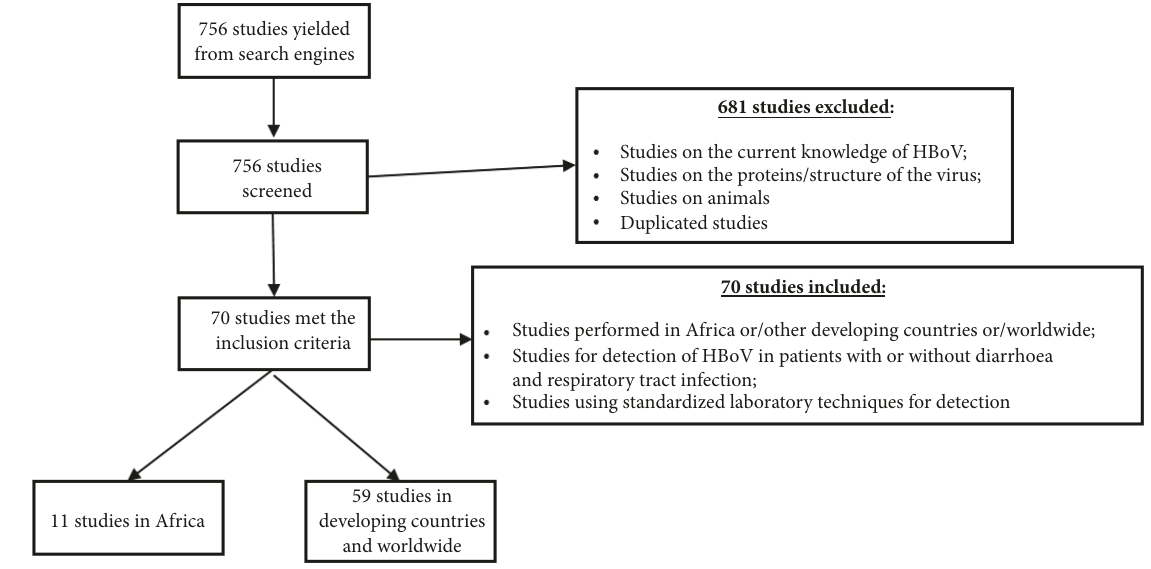
Figure 1: Schematic presentation of search engine